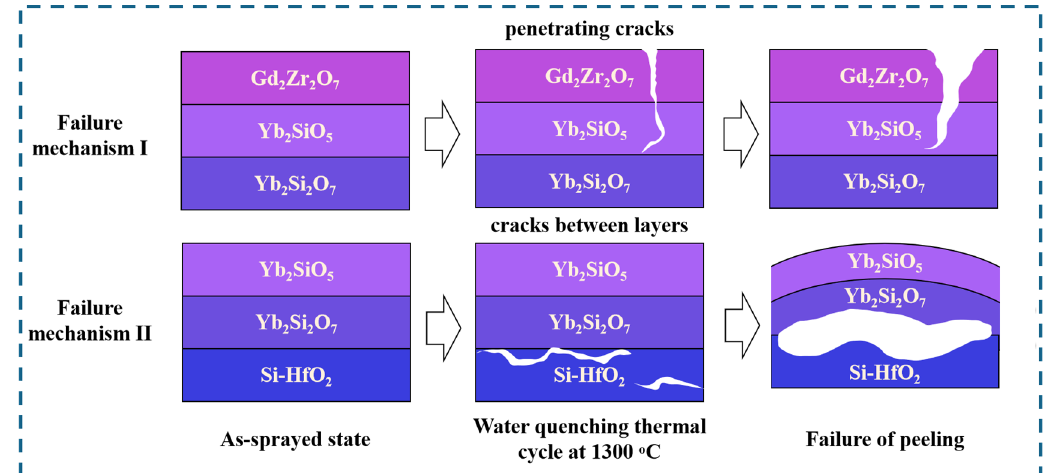
Figure 11. Schematic diagram of failure mechanism with T/EBCs coating after water quenching.